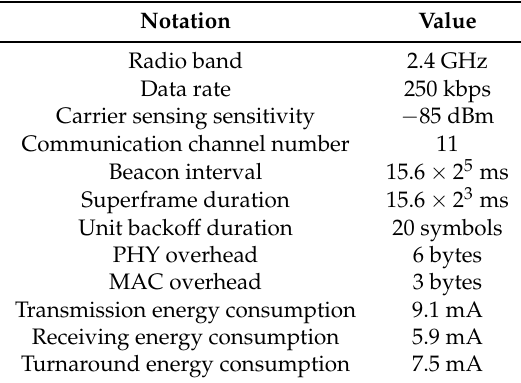
Table 2. Simulation